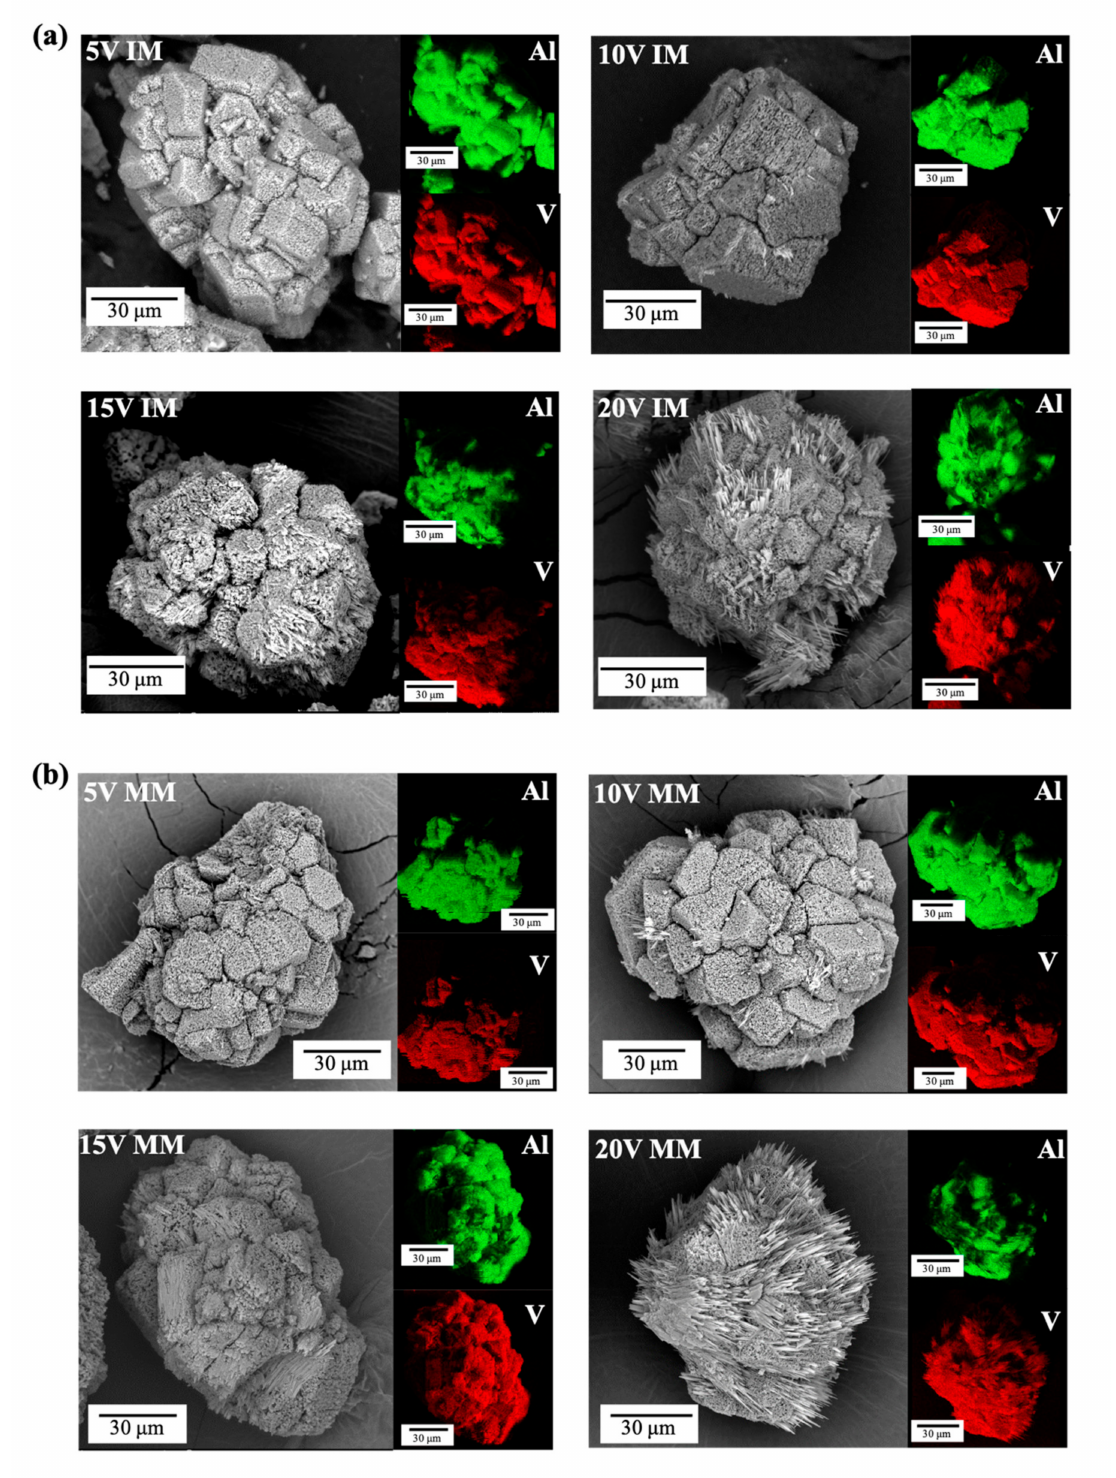
Figure 2. Morphologies and element distribution maps of V-based oxygen carriers with different V loadings: ( a ) Impregna- tion method; ( b ) Mechanical mixing